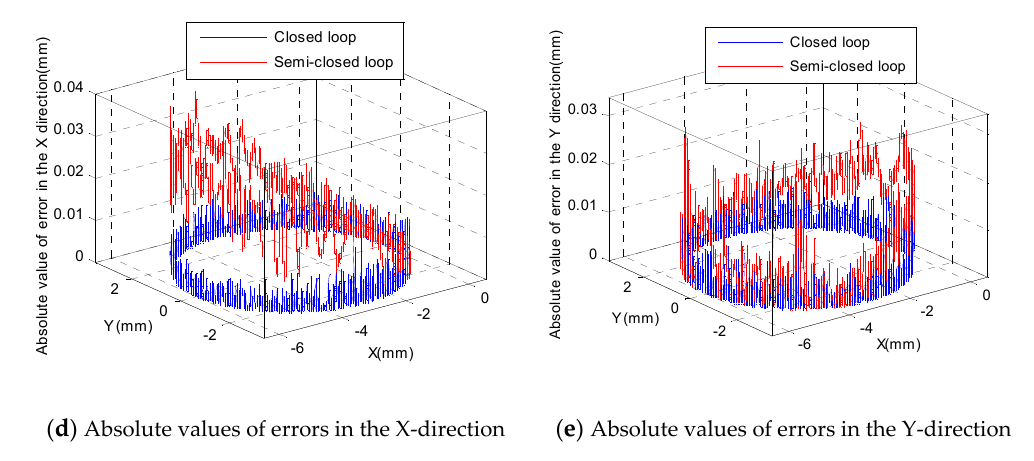
Figure 18. Neural-network-based experimental results of different circular trajectories. Table 3. Tracking accuracies of di ff erent control